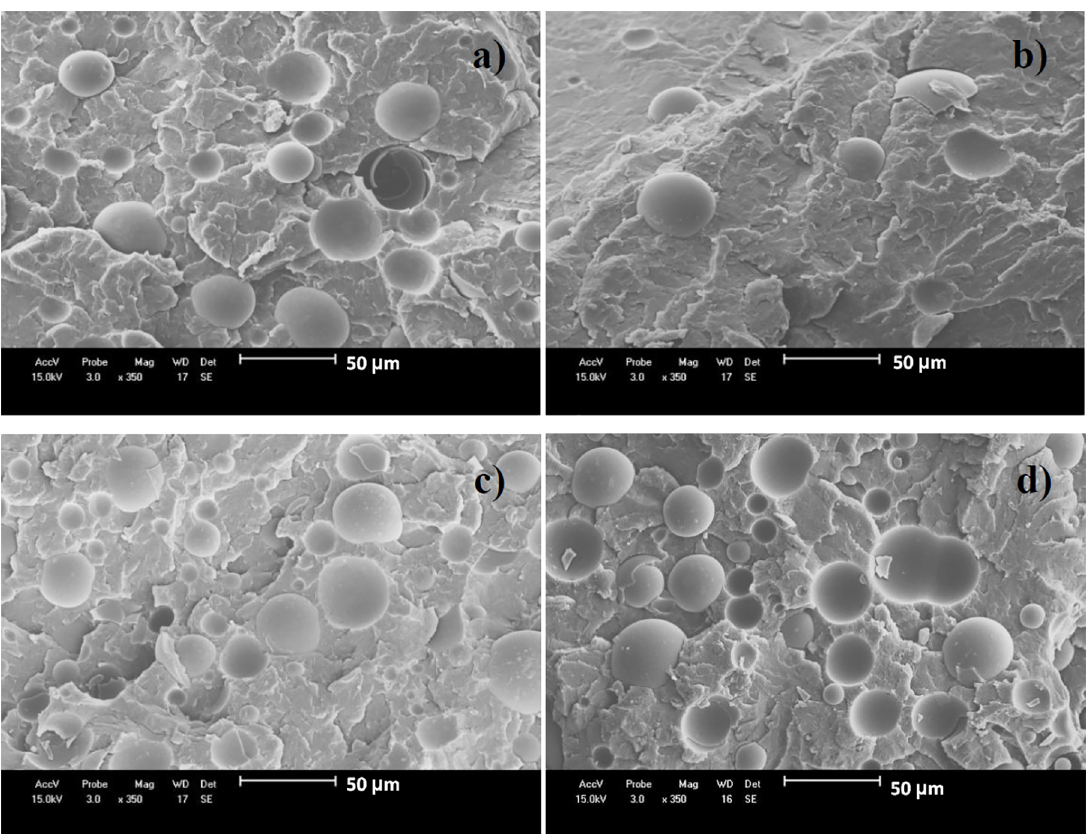
Figure 2. SEM micrographs of the composites with ABS/2.5 HGM/E1 (a), ABS/5.0 HGM/E1 (b), ABS/7.5 HGM/E1 (c) and ABS/5.0 HGM/E2